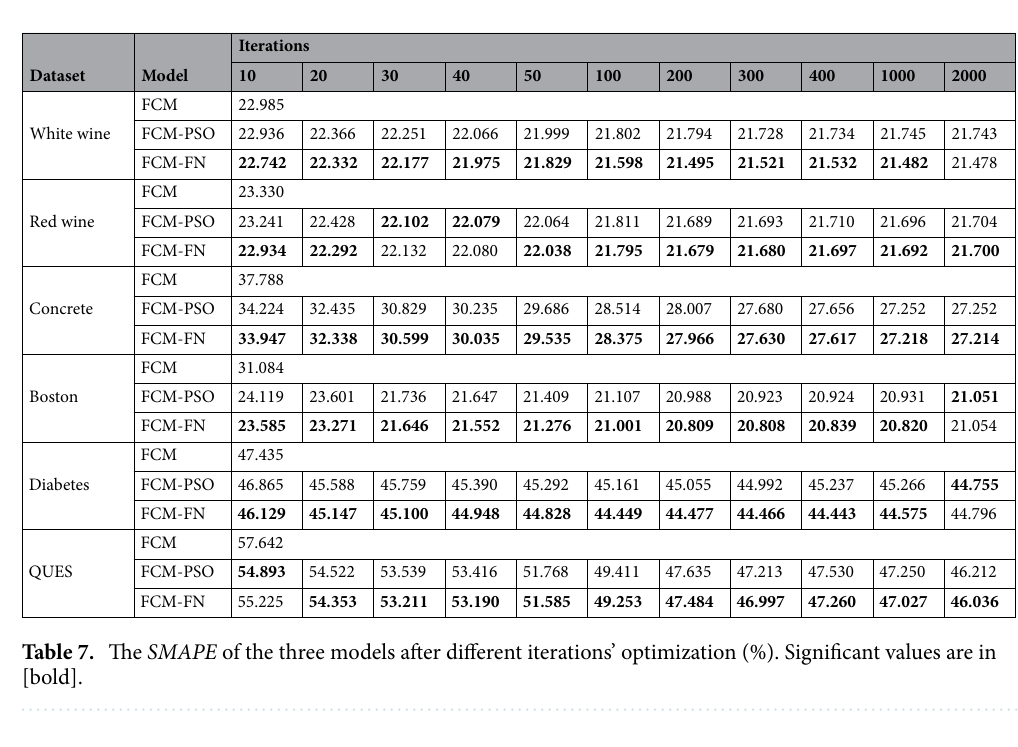
The improvement of FCM-FN compared